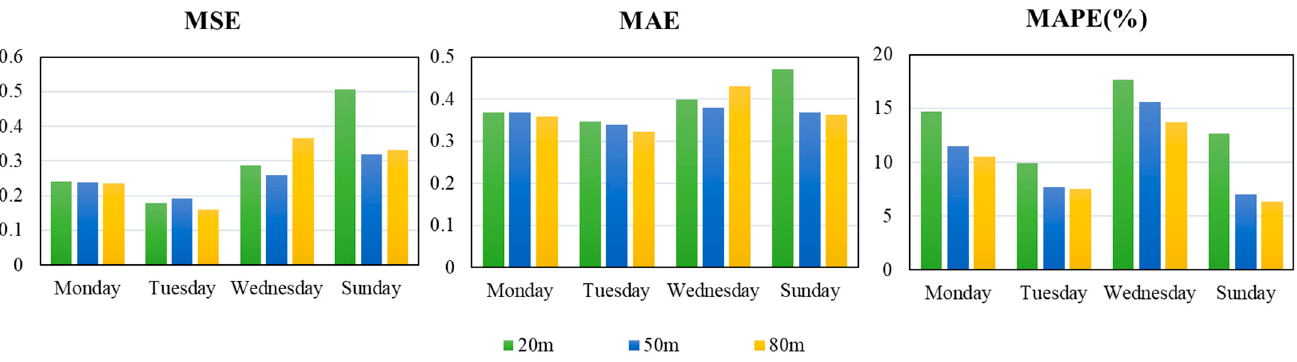
Table 2. The evaluation index of the ELM network.